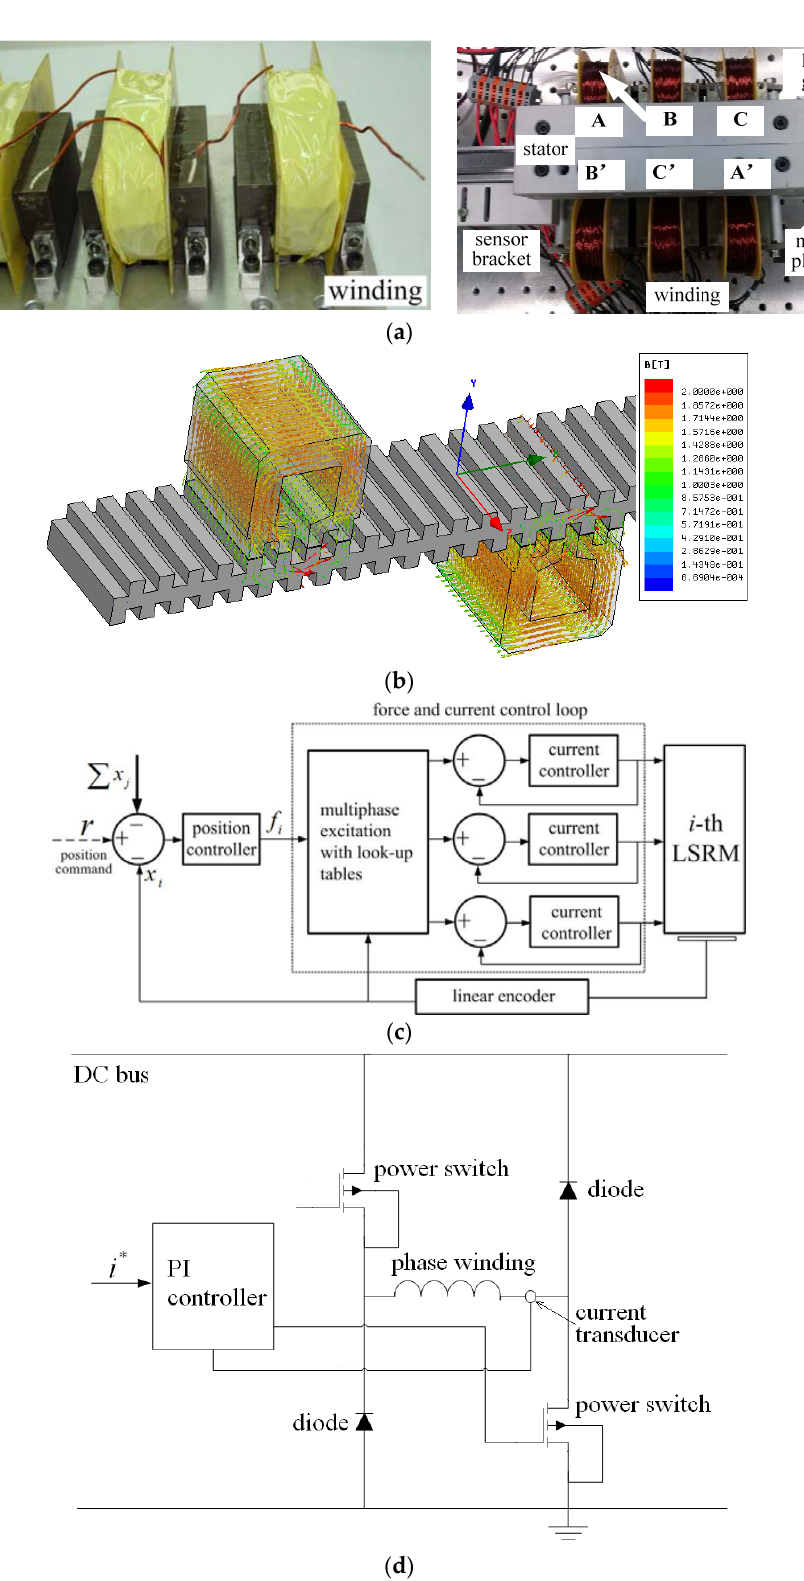
Figure 1. ( a ) The linear switched reluctance machine prototype ( b ) finite element analysis of flux ( c ) block diagram for a single LSRM node and ( d ) power electronic drive circuit.